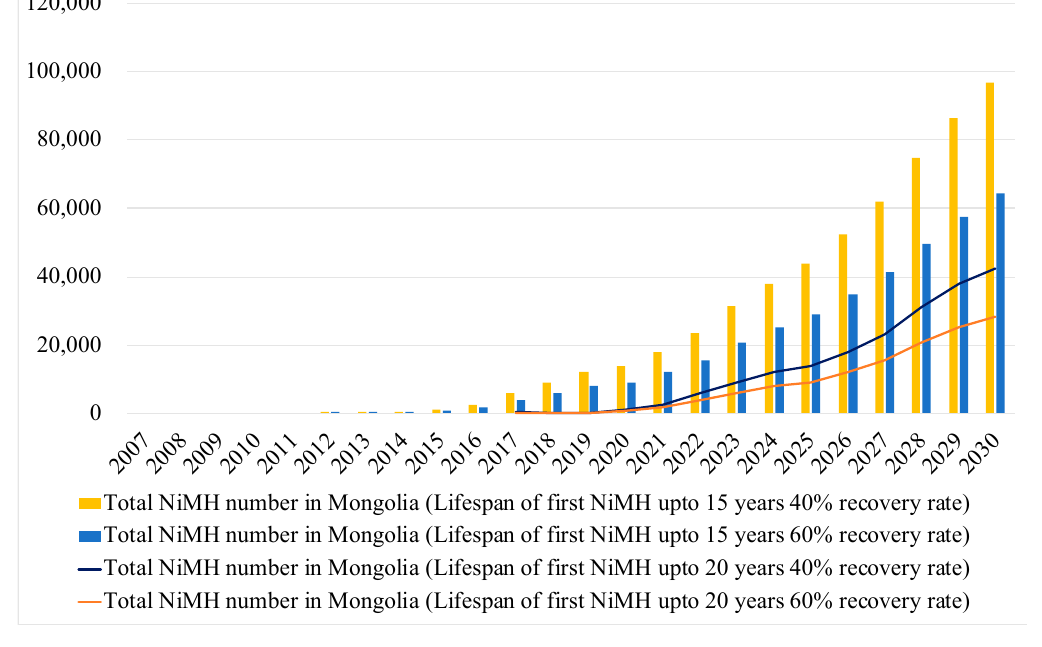
Figure 11. Scenario analysis of waste NiMH number considering reuse rate. Source: Figure made by